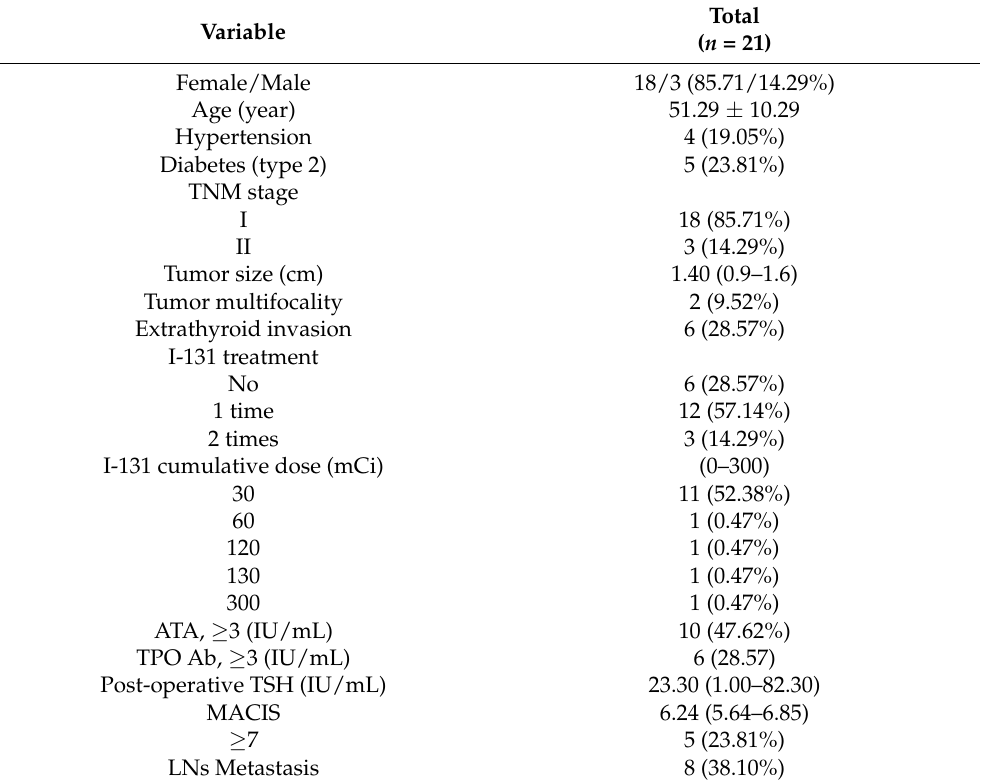
Table 1. Characteristic of baseline demography of enrolled patients.